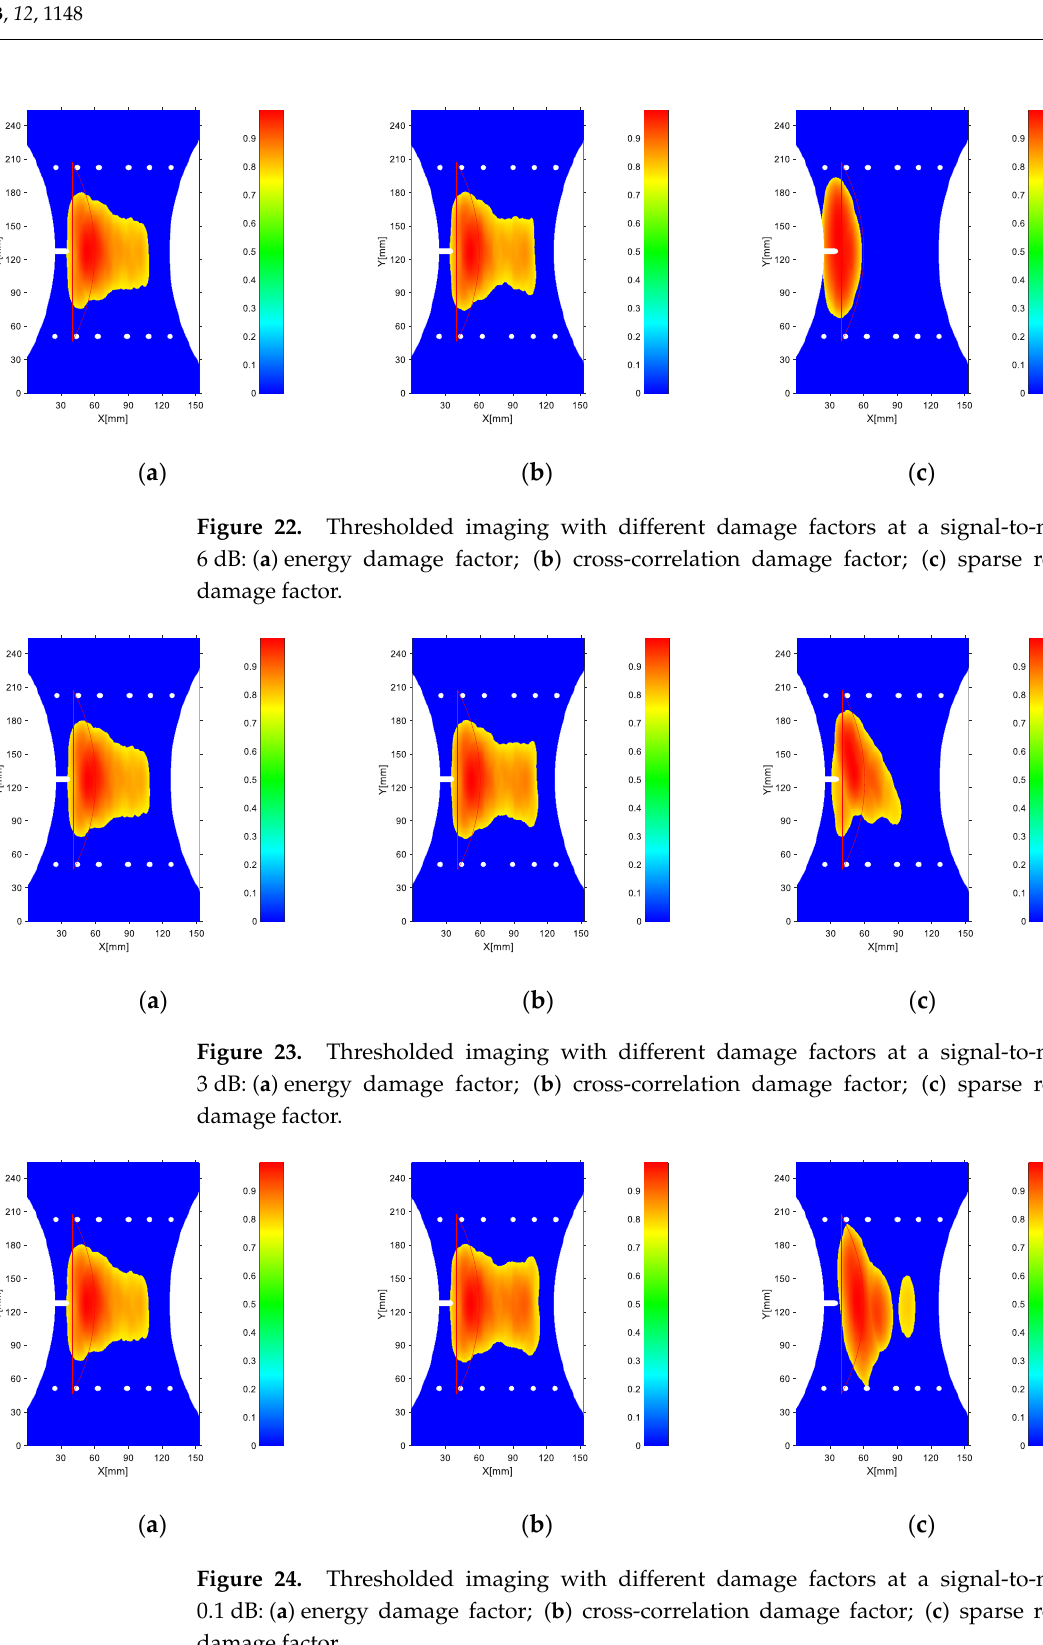
Figure 21. Imaging results with different damage factors at a signal-to-noise ratio of 0.1 dB: ( a ) en-